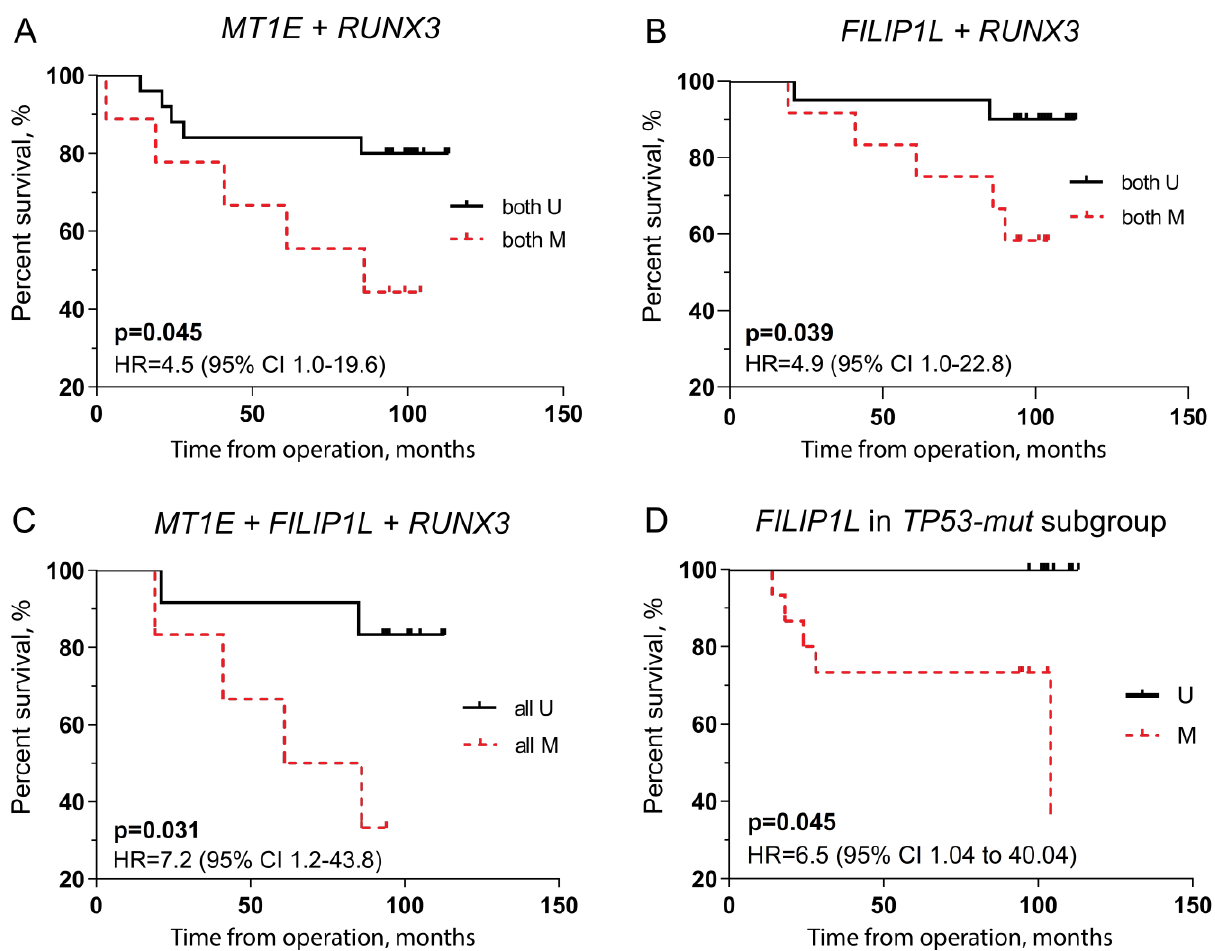
Figure 4. Overall survival prediction using RUNX3 in combination with MT1E (N = 9 vs. 27; corrected p = 0.180) ( A ) and FILIP1L (N = 14 vs. 22; corrected p = 0.156) ( B ), three biomarkers combination (N = 6 vs. 13; corrected p = 0.124) ( C ), and FILIP1L in the TP53-mut BC subgroup (N = 15 vs. 8; corrected p = 0.180) ( D ). CI: confidence interval; HR: hazard ratio; M — methylated and U — unmethylated status of biomarker; TP53-mut — TP53 mutated.